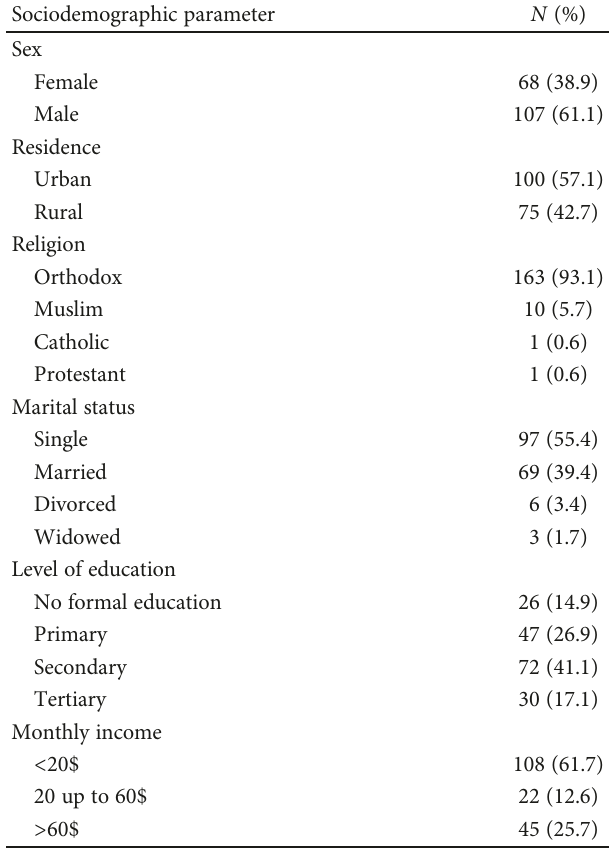
Table 1: Sociodemographic characteristics of